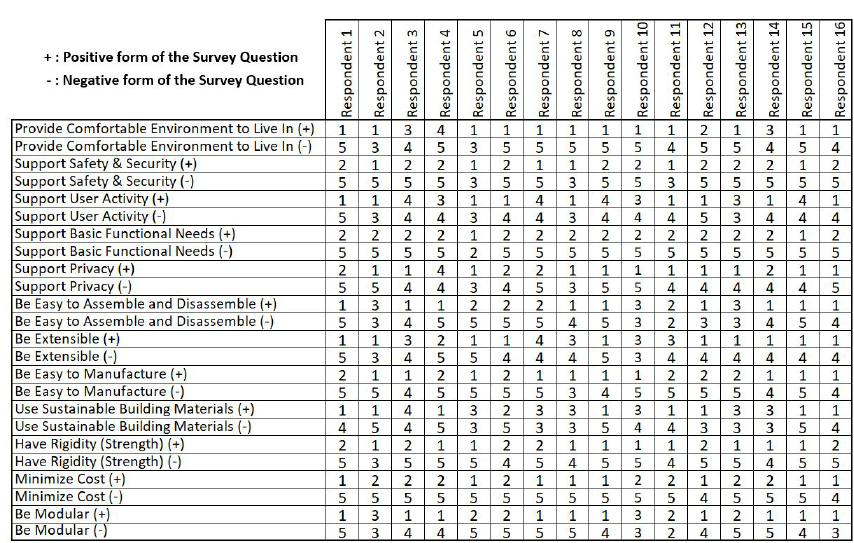
Figure A1. Kano Survey Results by